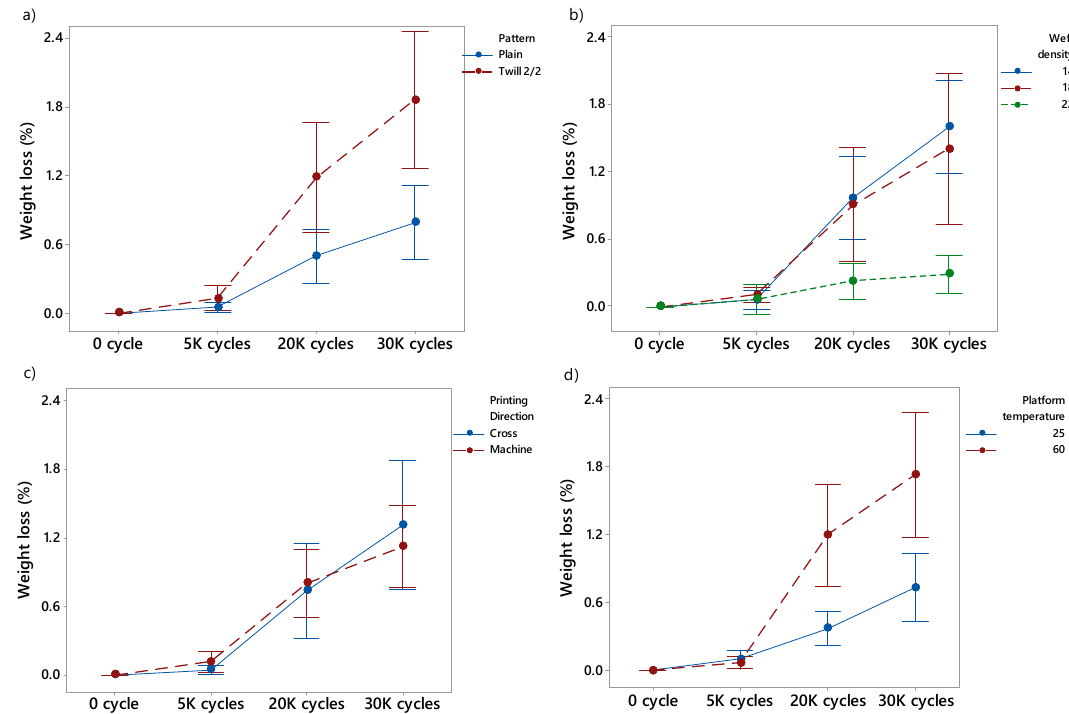
Figure 6. Weight loss (%) of the 3D-PPOT conductive materials after 0 cycles, 5000 (5 K), 20,000 (20 K) and 30,000 (30 K) rubbing cycles using two di ff erent patterns ( a ) plain in blue and twill 2 / 2 in red, three di ff erent weft densities ( b ) 14, 18 and 22 in blue, red and green, respectively, two di ff erent printing directions ( c ) cross in blue and machine in red and two di ff erent platform temperatures ( d ) 25, 60 ◦ C in blue and red,